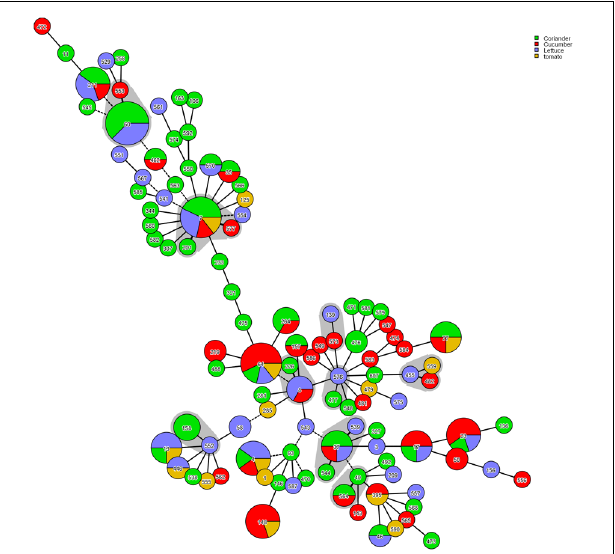
FIGURE 3 | Genetic relationships among the strains isolated in this study. A minimum spanning tree was constructed in BioNumerics software according to relationships among MLST alleles. Strains sharing four or more alleles are surrounding by a gray